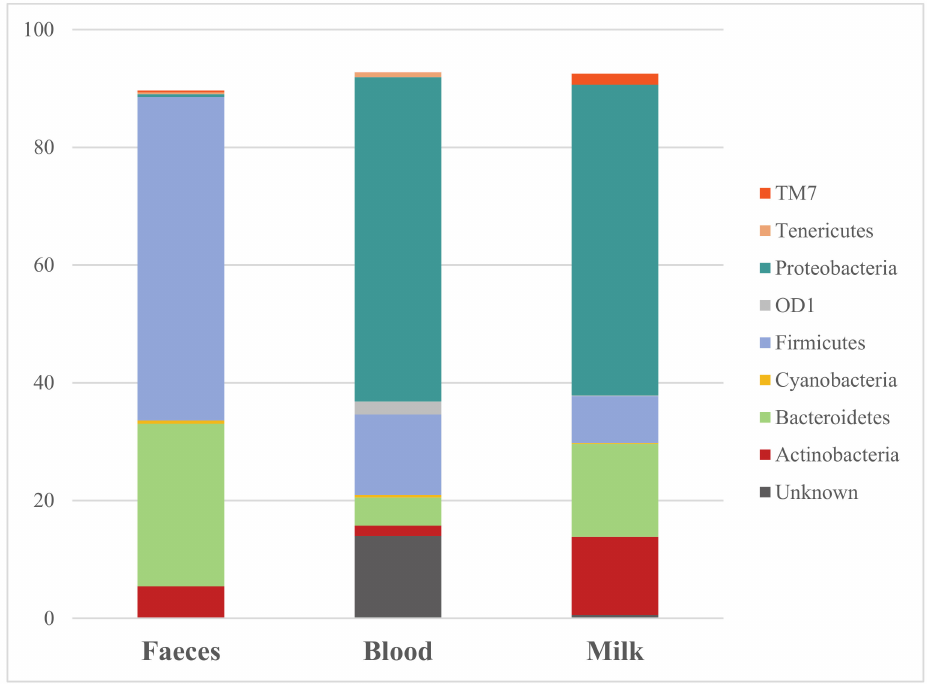
Figure 1. Microbiome composition at a phylum taxonomic level in feces, blood and milk sampled from lactating cows of all